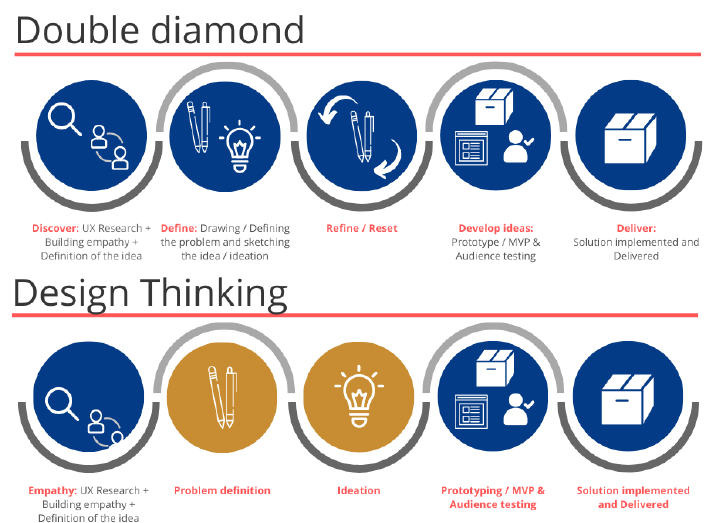
Figure 1. Double diamond processes and design thinking [elaborated by authors].